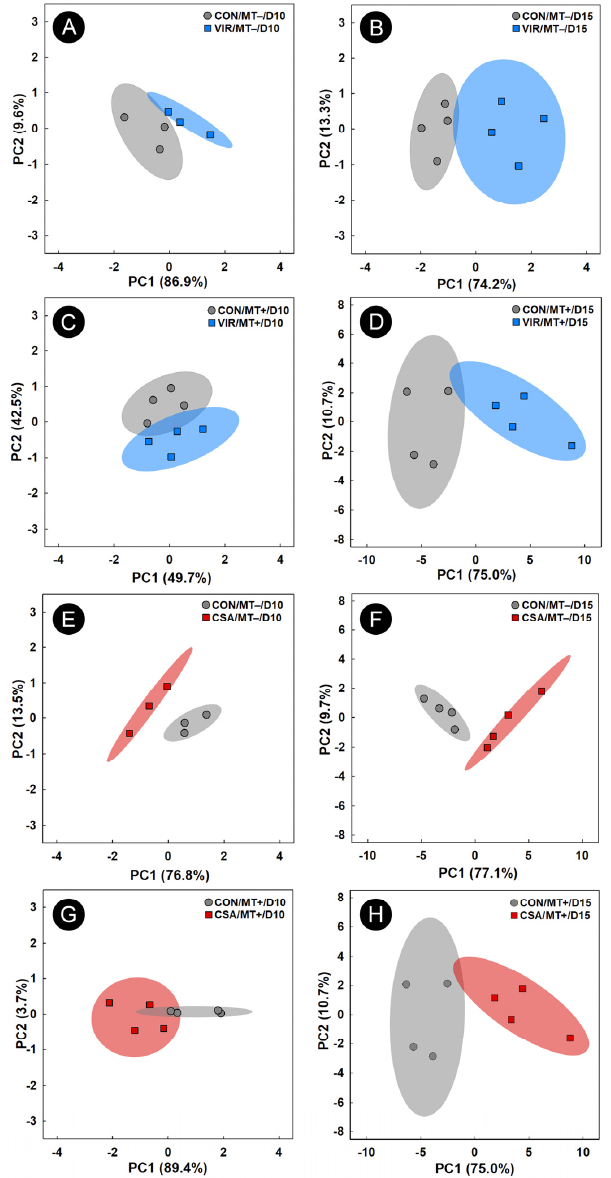
Figure 7. Principal component analysis score plots of metabolite bins in cecal digesta of broiler chicks administered an unamended starter diet (CON), a diet supplemented with virginiamycin (VIR), or a diet supplemented with the ceragenin, CSA-44 (CSA). Birds received a microbiota transplant (MT+) or buffer alone (MT–), and samples were analyzed 10 days post-hatch (D10) and 15 days post-hatch (D15). Each marker represents one bird, and shaded ellipses represent 95% confidence intervals. The x- and y-axes show principal components one and two, respectively, with the number in brackets indicating the percent variance of each component. Metabolite bins were determined to differ ( p ≤ 0.050) according to a Mann–Whitney U-test. ( A ) CON/MT– vs. VIR/MT– at day 10; ( B ) CON/MT– vs. VIR/MT– at day 15; ( C ) CON/MT+ vs. VIR/MT+ at day 10; ( D ) CON/MT+ vs. VIR/MT+ at day 15; ( E ) CON/MT– vs. CSA/MT − at day 10; ( F ) CON/MT– vs. CSA/MT − at day 15; ( G ); CON/MT+ vs. CSA/MT+ at day 10; ( H ) CON/MT+ vs. CSA/MT+ at day